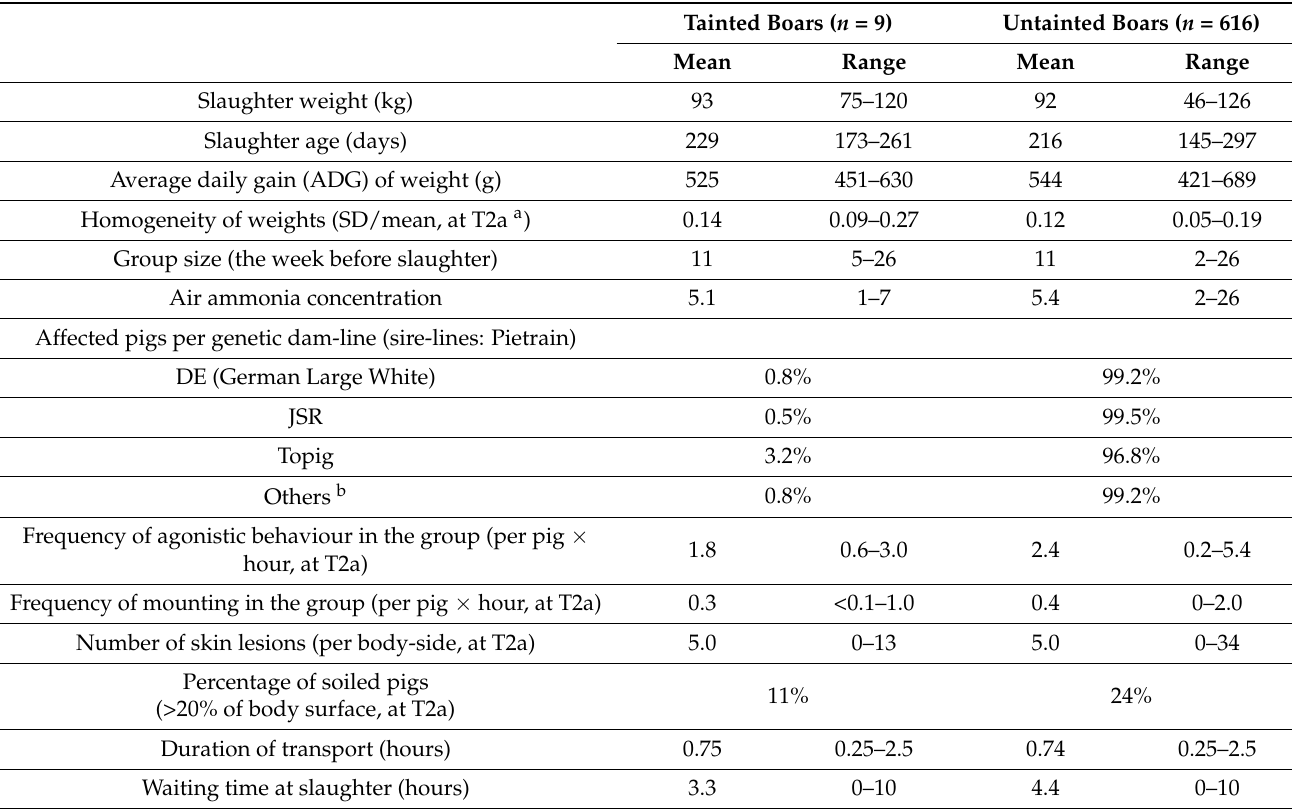
Table 8. Retrospective comparison of tainted and untainted boars concerning potentially influencing conditions around